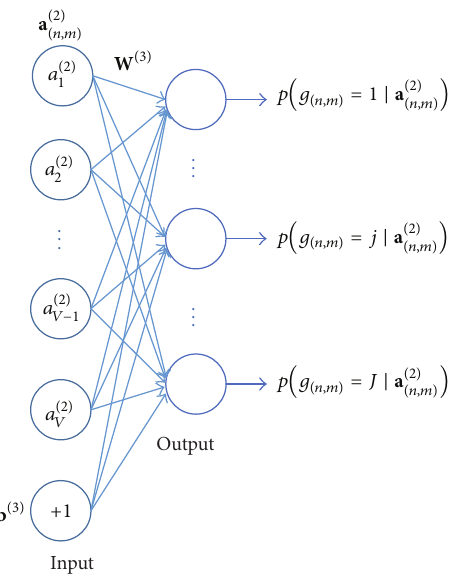
Figure 8: A calssical architecture of the softmax classifier.